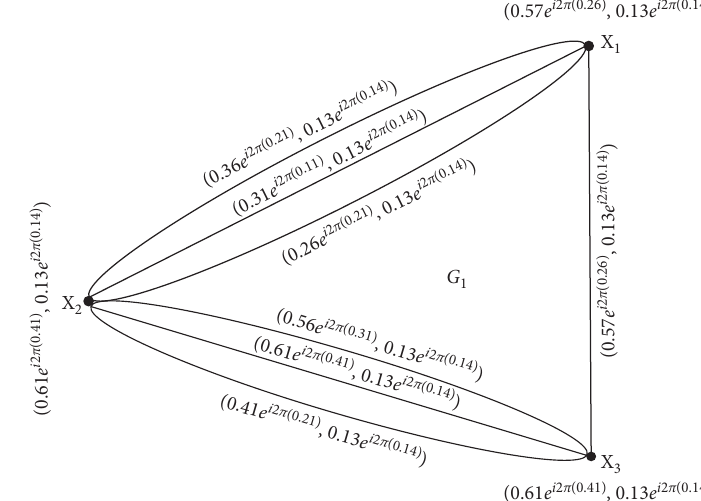
Figure 11: Complex q-rung orthopair fuzzy dual graph G